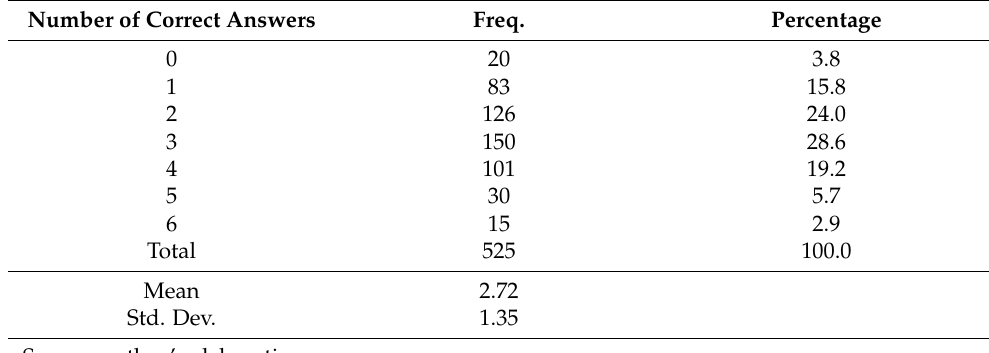
Table 2. Number of correct answers in the objective financial knowledge test.